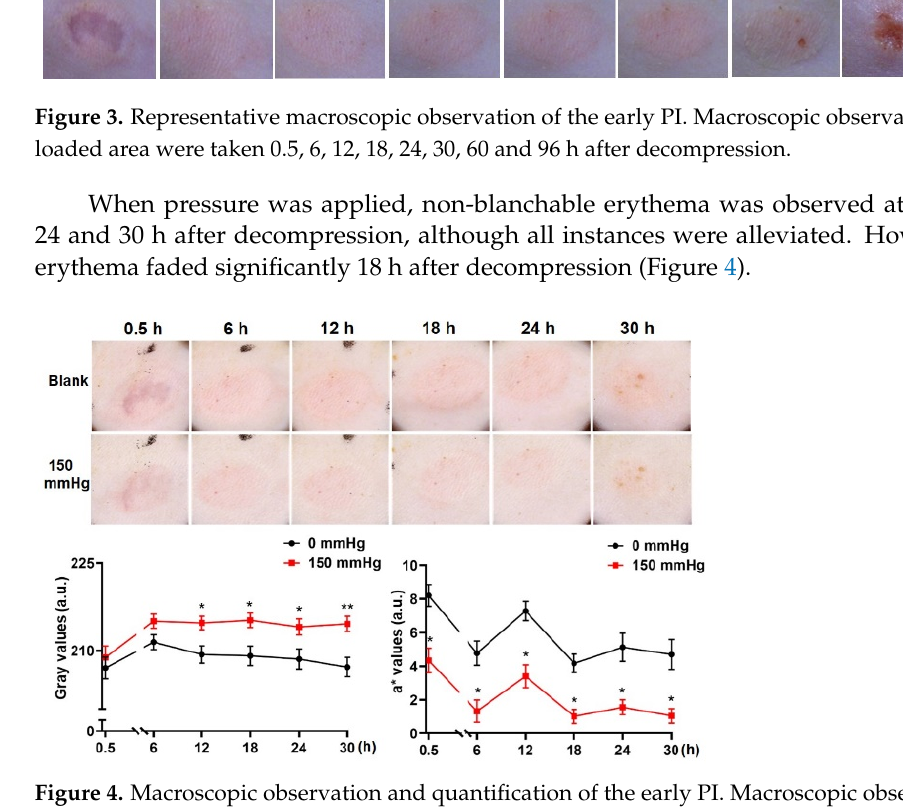
Figure 4. Macroscopic observation and quantification of the early PI. Macroscopic observations of the loaded area were taken 0.5, 6, 12, 18, 24 and 30 h after decompression. The pressure range of the transparent disc method went from blank and 150 mmHg. Representative pictures are shown in the top panel. The loaded area (gray value) was quantified using the Image J software and the erythema index was regarded as the a* value measured by the spectrophotometer. ( bottom ; n = 8 for each group; * p < 0.05, ** p < 0.01 vs. blank via 1-way ANOVA and Dunnett’s post hoc